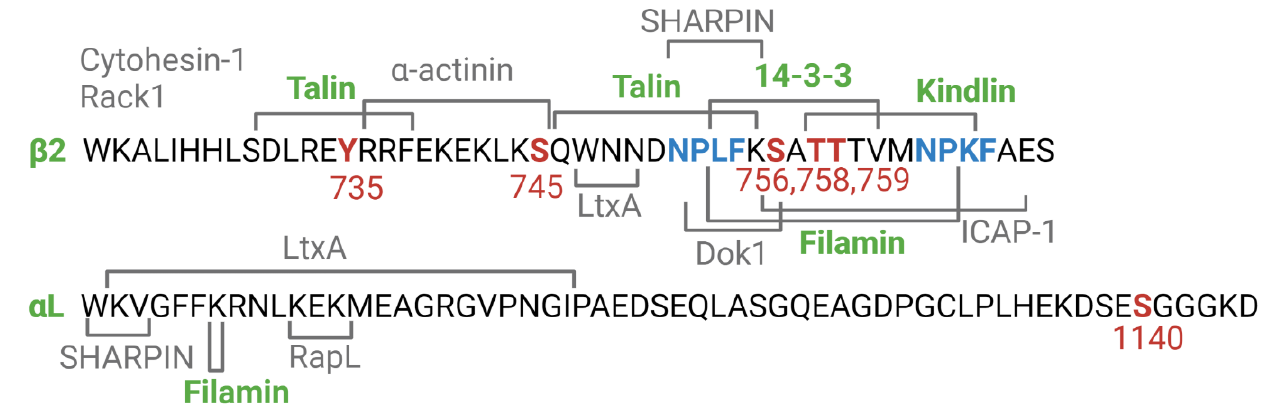
Figure 2. Binding sites of cytoplasmic proteins in LFA-1. The important NPXY/F motifs are in blue. The best studied proteins that are important in integrin crosstalk are coloured in green and the phosphorylation sites in red.